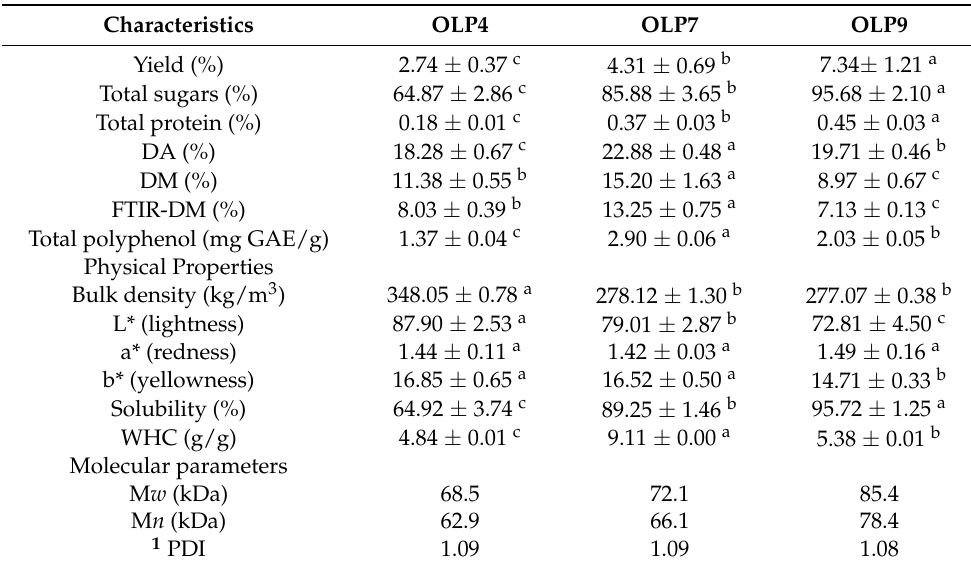
Table 1. Physicochemical properties and molecular weights of polysaccharides from okra leaves